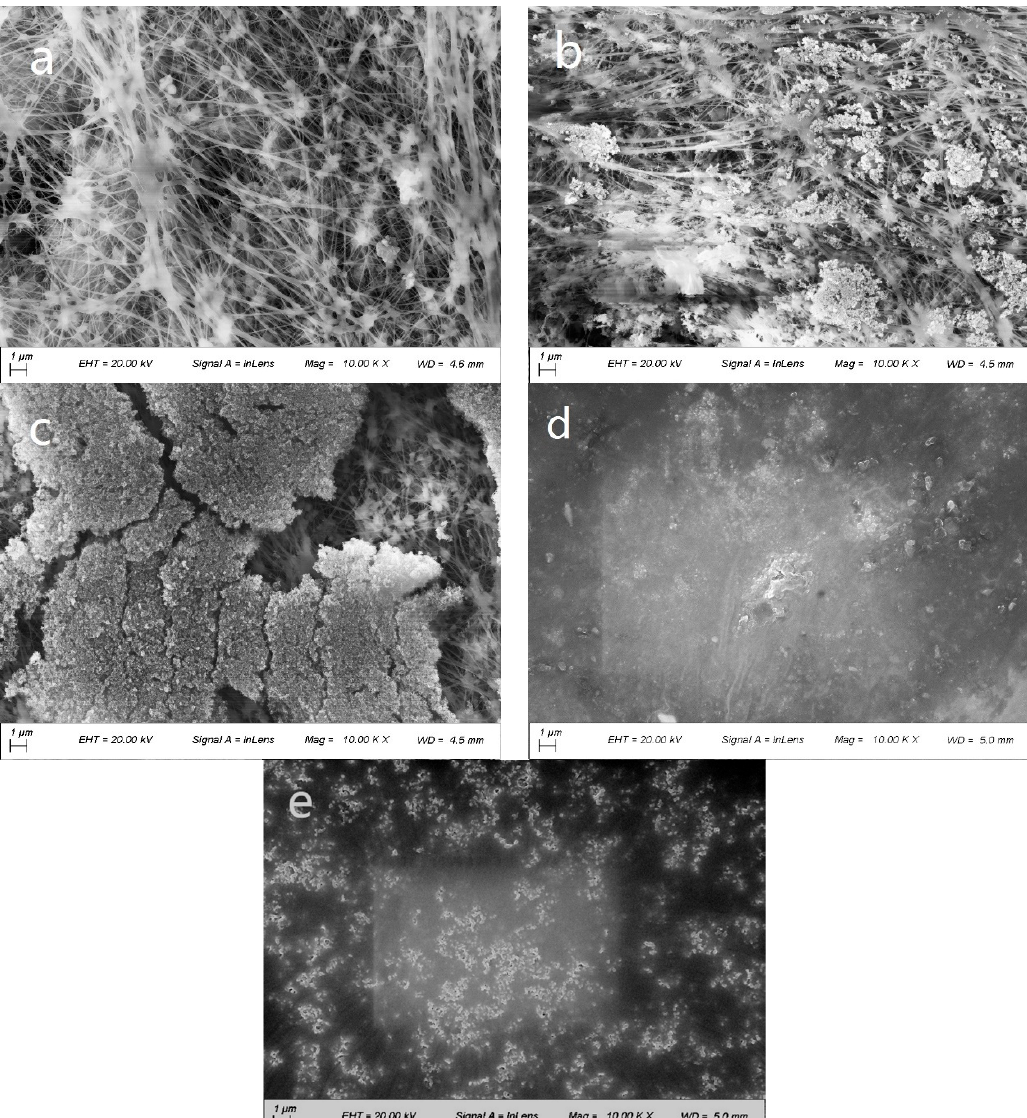
Figure 3. Scanning electron microscopy (SEM) image of the modified membrane surface: ( a ) Polyvinylidene Fluoride (PVDF) membrane; ( b ) TiO 2 /PVDF membrane; ( c ) nitrogen-doped TiO 2 (NT)/PVDF membrane; ( d ) TiO 2 -graphene oxide (TG)/PVDF membrane and ( e ) nitrogen-doped TiO 2 /graphene oxide NTG/PVDF membrane.